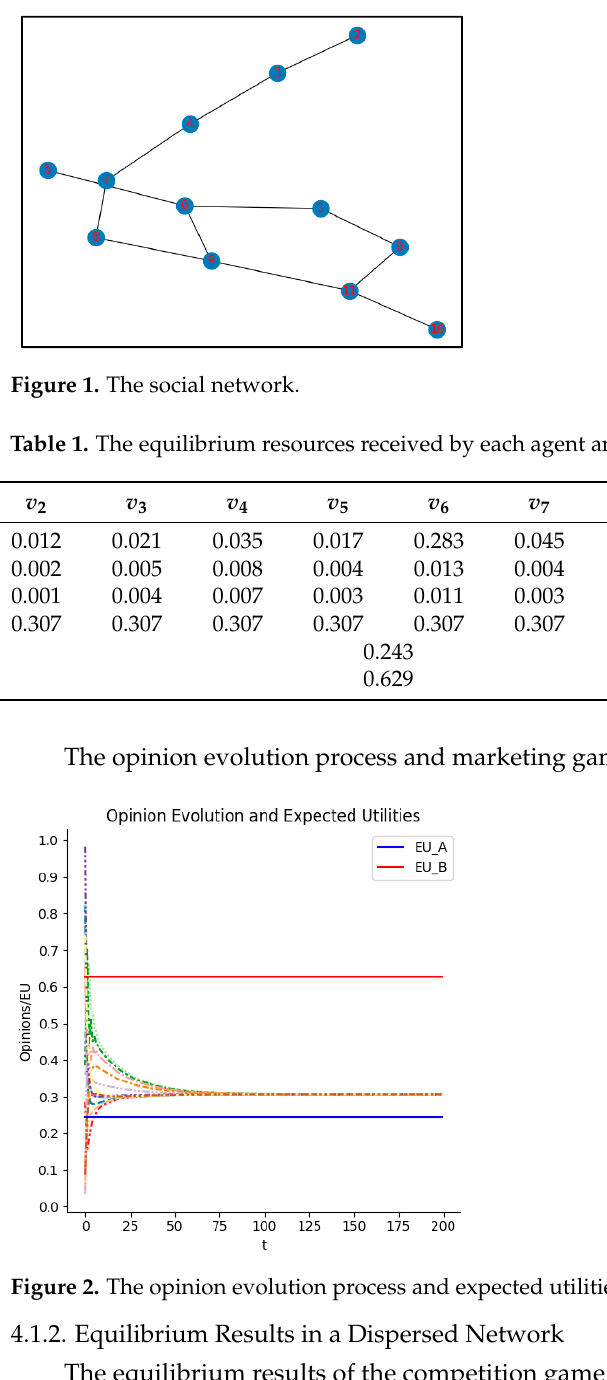
Figure 2. The opinion evolution process and expected utilities of firms A and B.